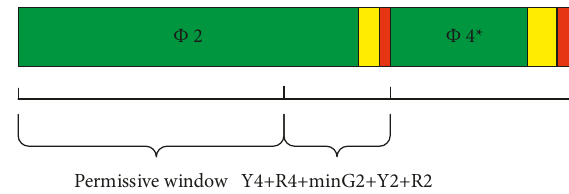
Figure 1: Permissive window of two phase control. Y4: yellow time of phase 4; R4: all red time of phase 4; minG2: the minimum green of phase 2; Y2: yellow time of phase 2; R2: all red time of phase 2.